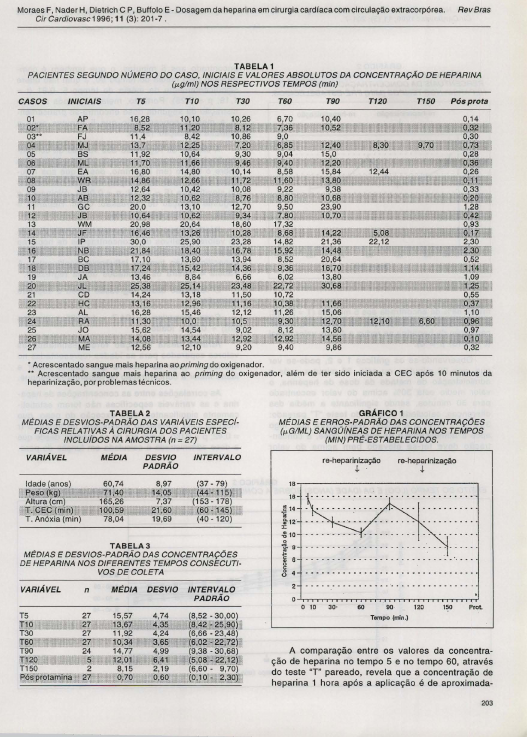
TABELA 2 MitO/AS E DESVIOS-PADRAo DAS VARIÁVEIS ESPECI FICAS RELATIVAS A CIRURGIA DOS PACIENTES INCLUíOOS NA AMOSTRA (n ..